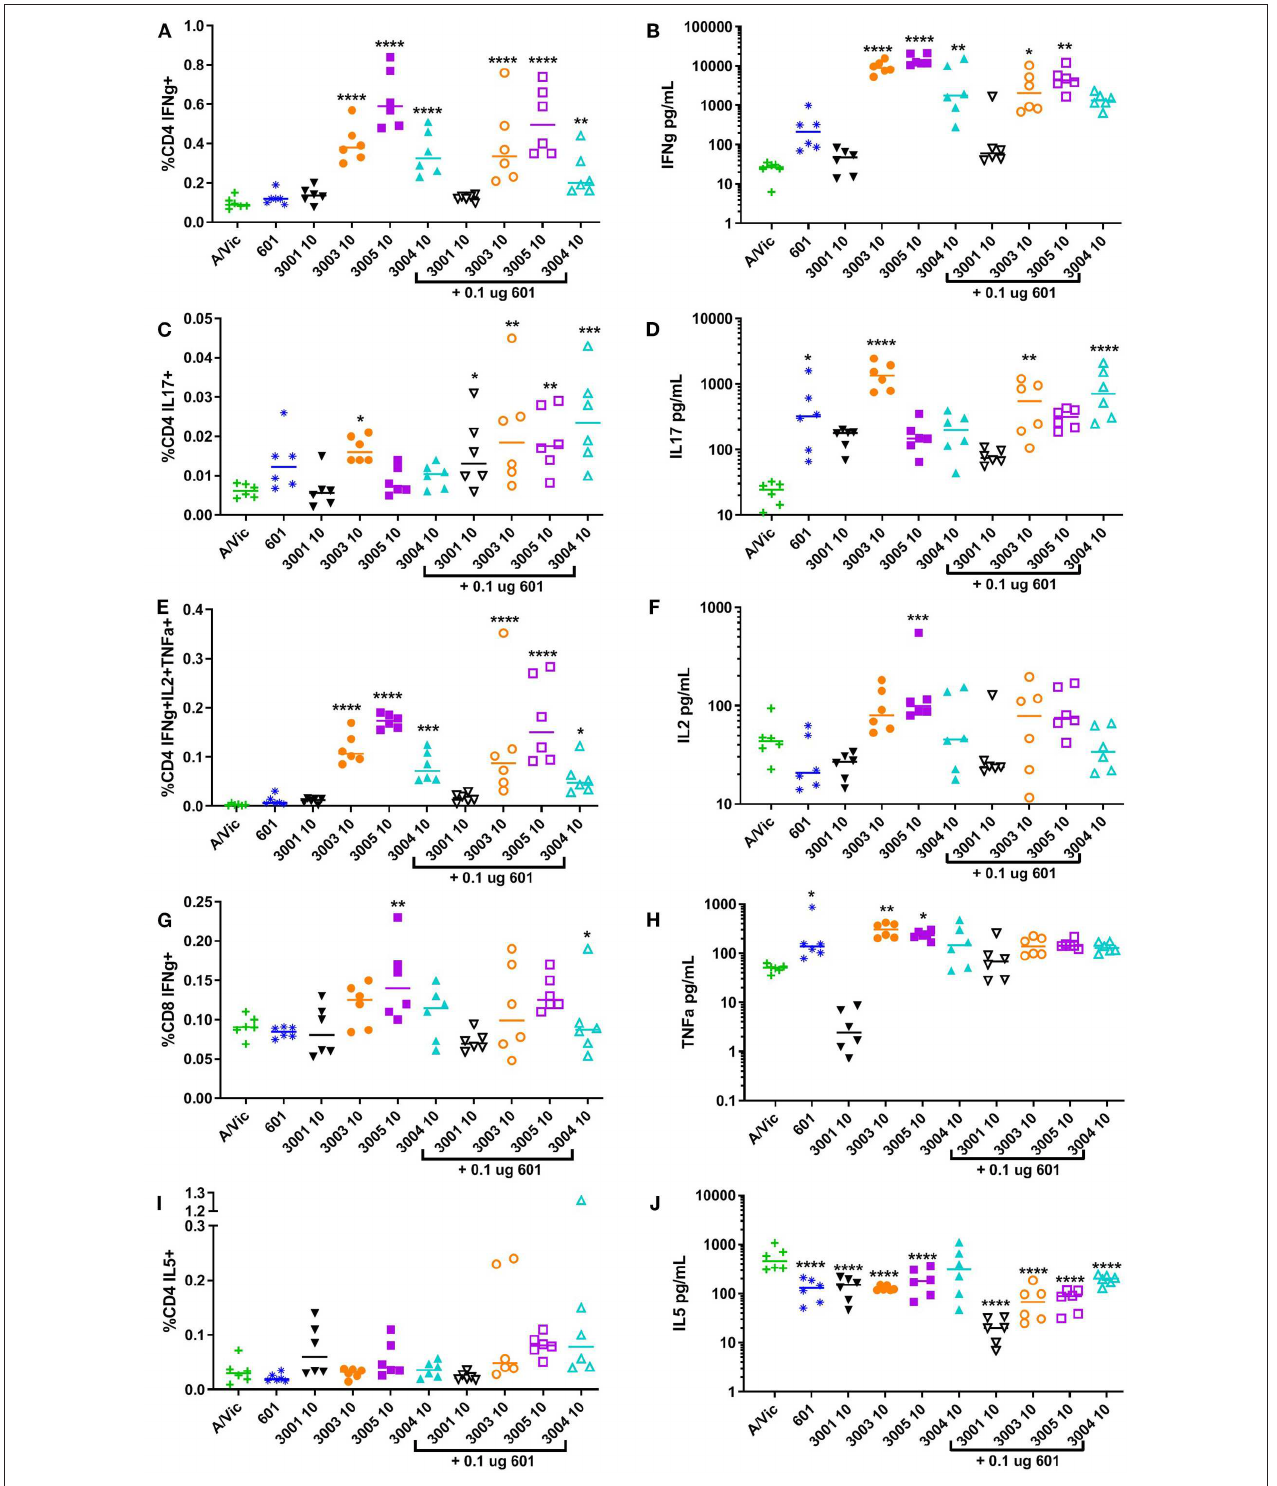
FIGURE 3 | High-dose lipidated imidazoquinolines elicit an influenza-specific Th1 response and, in combination with a TLR4 agonist, an influenza-specific Th17 response. Balb/c mice (6 per group) were injected twice i.m. fourteen days apart with 0.3 µ g/mouse A/Vic monovalent detergent-split influenza vaccine adjuvanted with indicated TLR4 (0.1 µ g/mouse), TLR7/8 (10 µ g/mouse), or combination TLR4 + TLR7/8 agonists. Five days post-secondary injection (5dp2), mice were